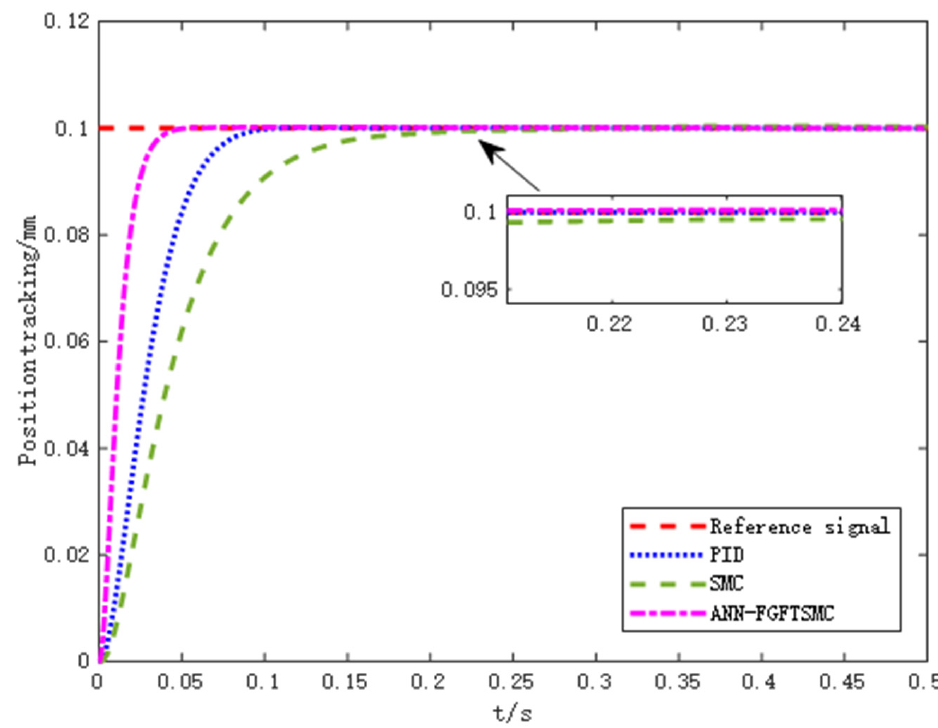
Figure 11. Position tracking curve.